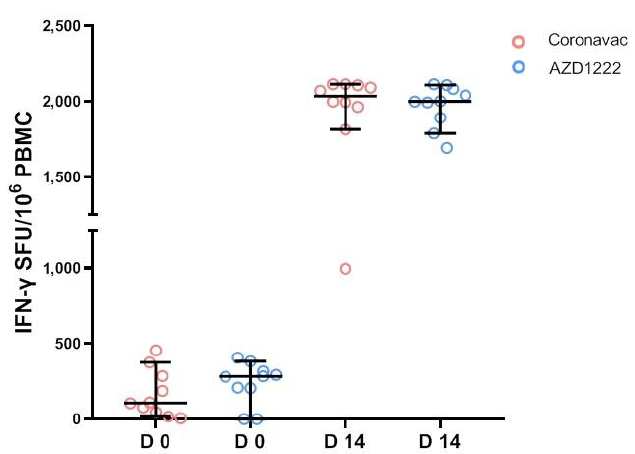
Figure 5. IFN- γ concentration before and day 14 after booster vaccination with mRNA-1273 in participants who received two doses of CoronaVac and two doses of AZD1222 . participants who received two doses of CoronaVac and two doses of